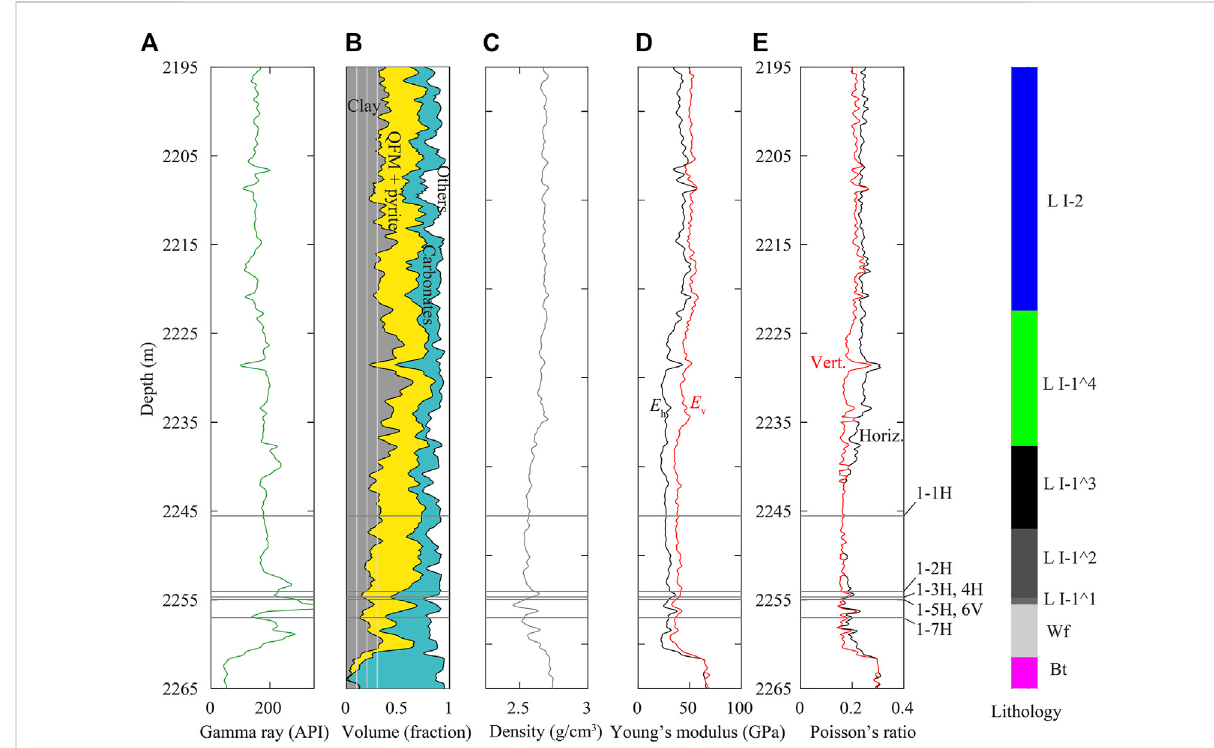
FIGURE 1 Integrated geophysical logs of Well 1: (A) Gamma ray; (B) Element Capture Spectroscopy (ECS); (C) Density; (D) Sonic log derived Young ’ s modulus; (E) Sonic log derived Poisson ’ s ratio. The coring depths of seven shale samples from Well 1 are shown with “ H ” and “ V ” denoting horizontal and vertical samples, respectively. For reference, the stratigraphic column is also shown where “ L ” , “ Wf ” , and “ Bt ” denote Longmaxi, Wufeng, and Baota formations,